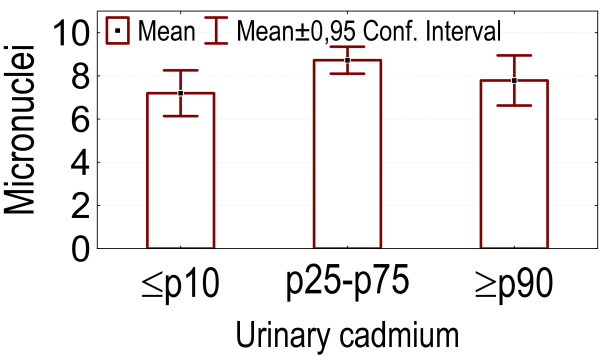
Categories of urinary cadmium concentrations: association with the number of micronuclei.